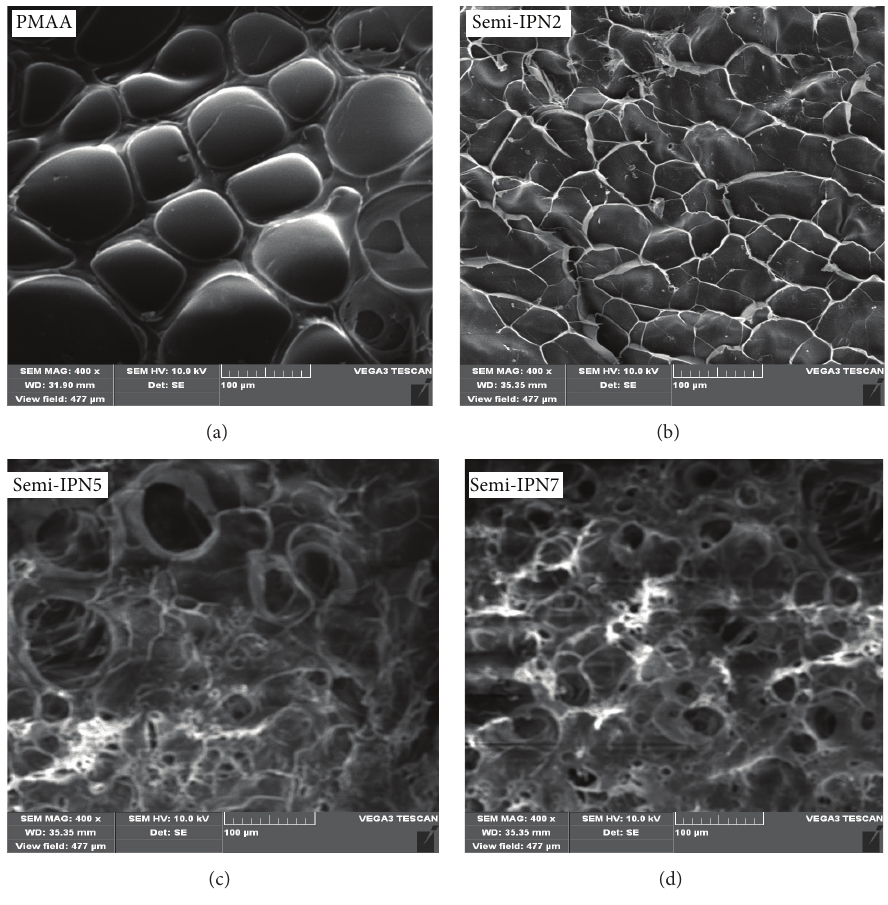
Figure 3: SEM images of PMAA (a), semi-IPN2 (b), semi-IPN5 (c), and semi-IPN7 (d).